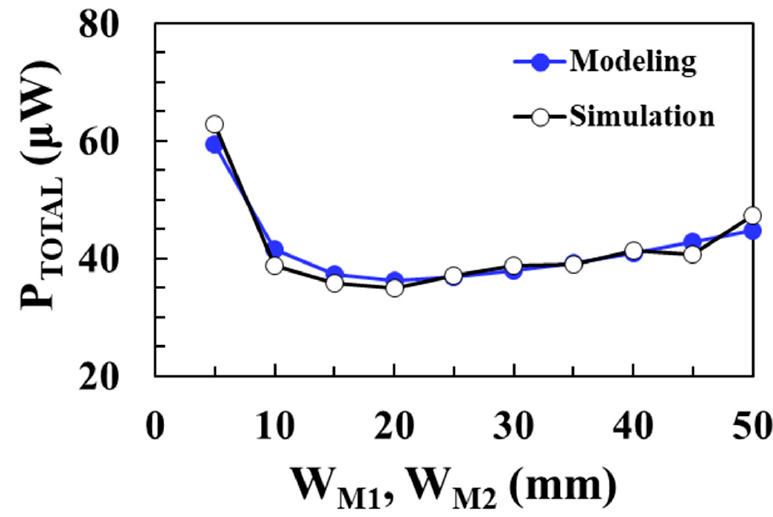
Figure 15. Total loss according to the switch width for an input voltage of 0.1 V and comparison with the modeling results.